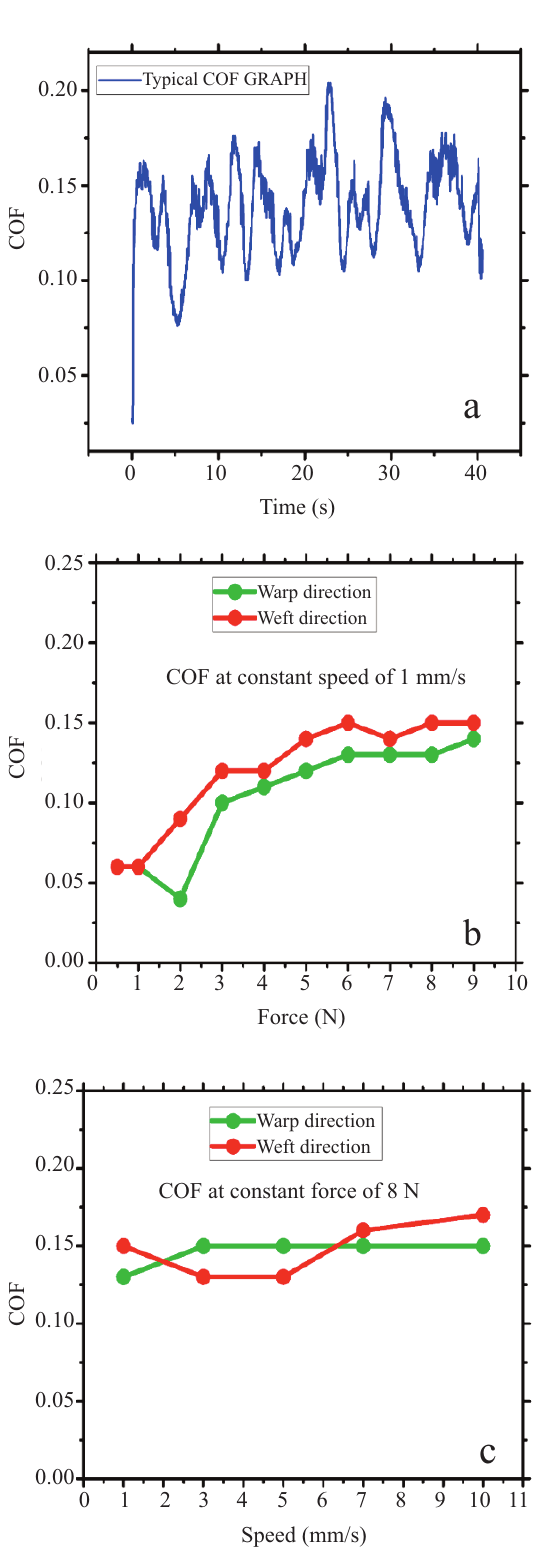
Fig. 5. (a) COF versus time, (b) COF versus force variations and (c) COF versus speed